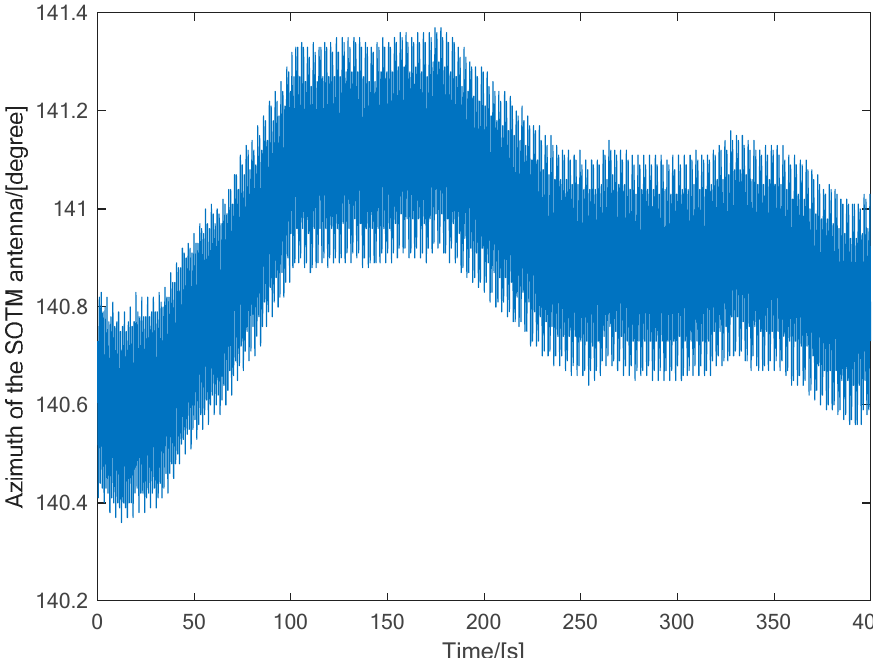
Figure 11. Azimuth angle of the SOTM antenna of the conventional method.